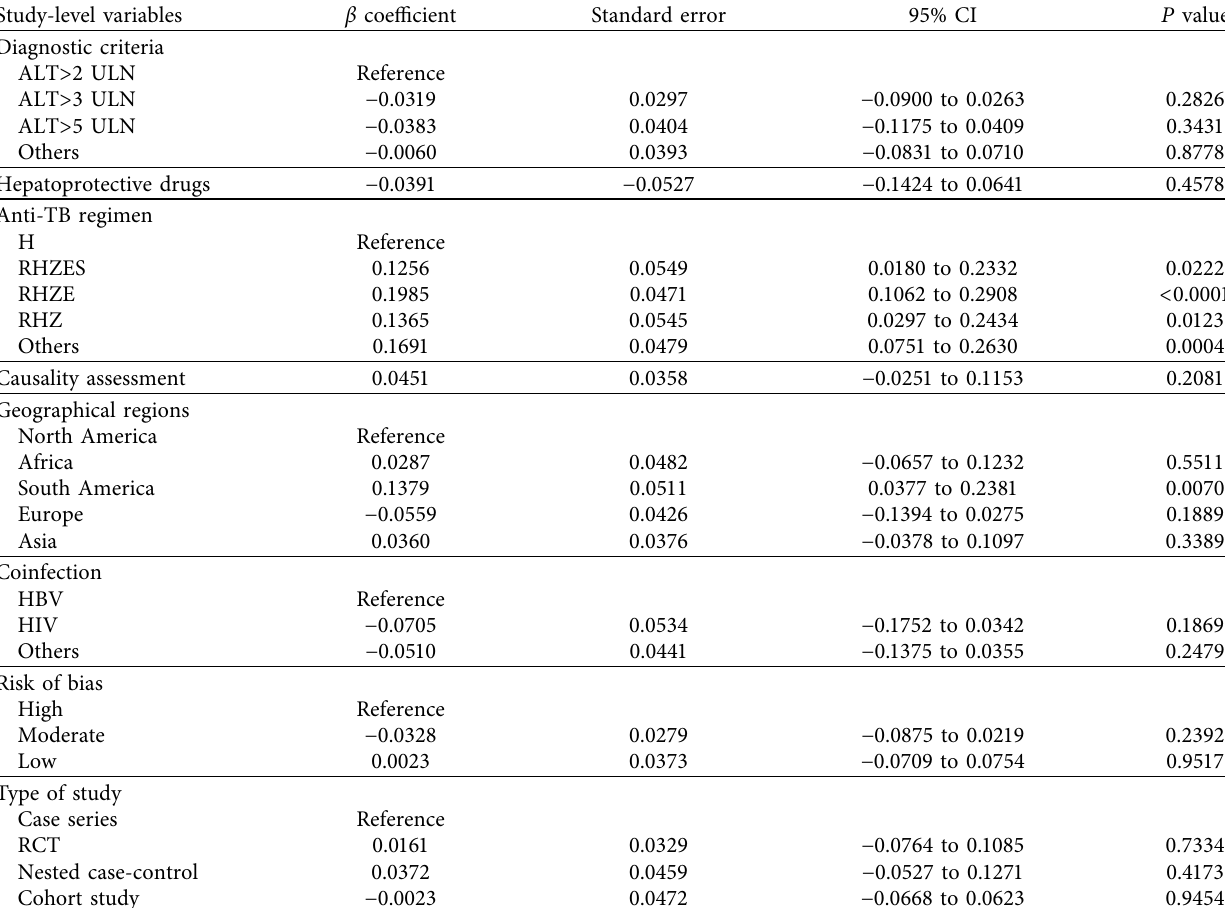
Table 3: Results of the metaregression in the pooled ATLI incidence